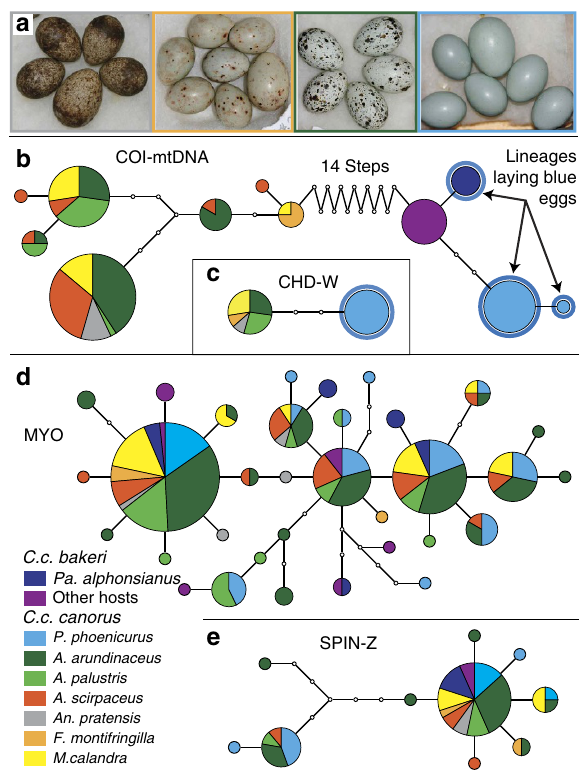
Figure 2 | Egg phenotypes and haplotype networks. ( a ) Examples illustrating host-specific egg mimicry and the tremendous variation in egg colour among common cuckoo host races. From left: meadow pipit Antus pratensis , brambling Fringilla montifringilla , great reed warbler Acrocephalus arundinaceus and common redstart Phoenicurus phoenicurus (in each clutch, the cuckoo egg is slightly larger). All photos by B.G.S. Haplotype networks for ( b ) COI—mitochondrial DNA, ( c ) CHD-W—nuclear W chromosome, ( d ) MYO—nuclear autosomal (2N) and ( e ) SPIN—nuclear Z chromosome, all sequenced in common cuckoo host races from Europe and Asia. Each coloured circle represents a unique haplotype, the relative frequency of which in our sample is proportional to area. Samples from females of different host races are colour-coded as indicated. Each line segment represents a single nucleotide difference, with small open circles indicating intermediate haplotypes not found in our sample. Sample size for the autosomal MYO gene is larger because each sample yields two sympatric population were strictly associated with the two different mitochondrial lineages (Supplementary Table 6). Hence, blue egg colouration must be maternally inherited.